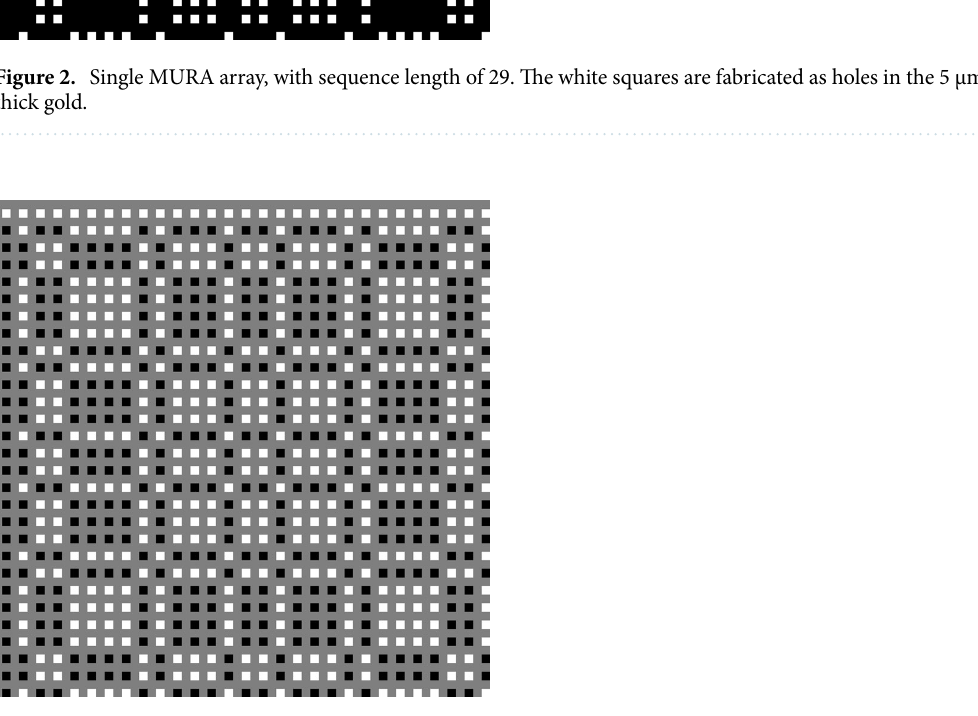
Figure 3. Visual representation of the decoding array used to reconstruct the X-ray spot image. Black is − 1, grey is zero, and white is +